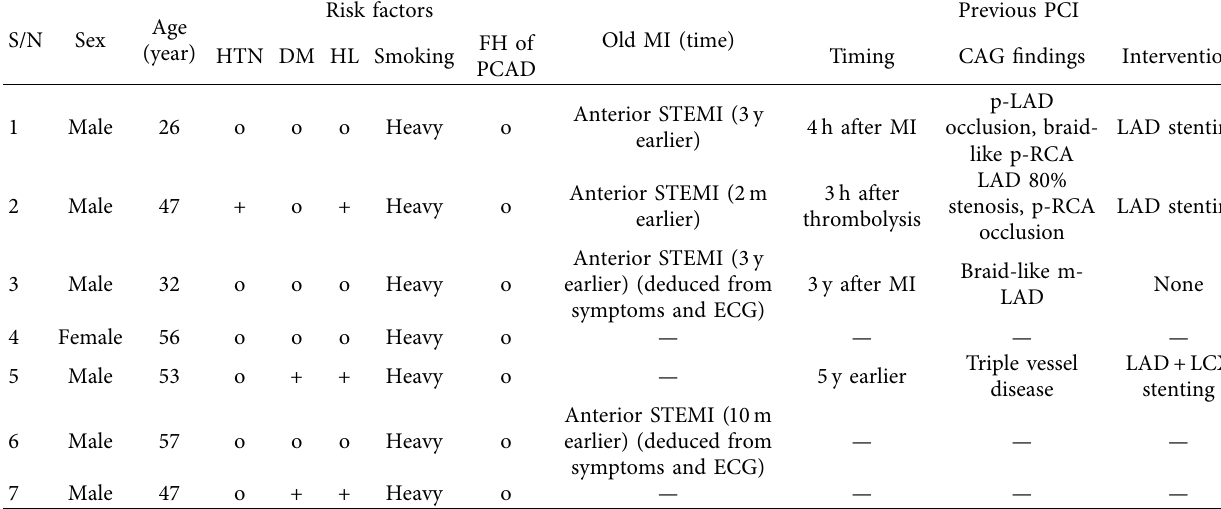
Table 1: Demographic characteristics, risk factors, and past history.